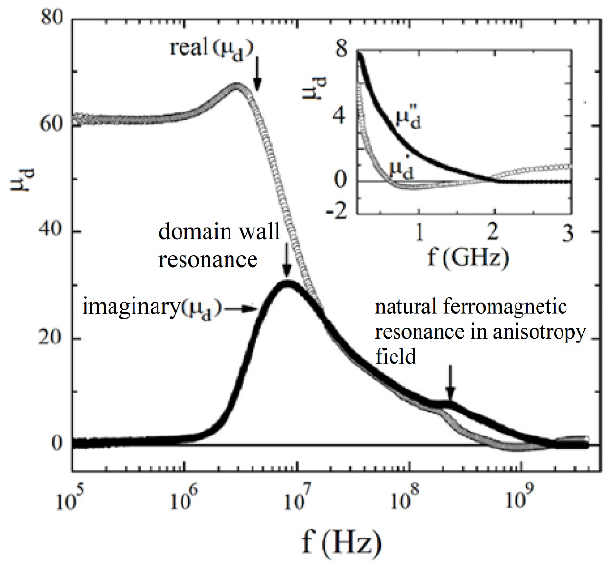
Figure 12. Measurement results of the initial permeability for polycrystalline YIG sample having a thickness of 1.0 mm, and employing coaxial line transmission/reflection cell with the outer diameter of 7 mm. © Reproduced from [65], with the permission of AIP Publishing.